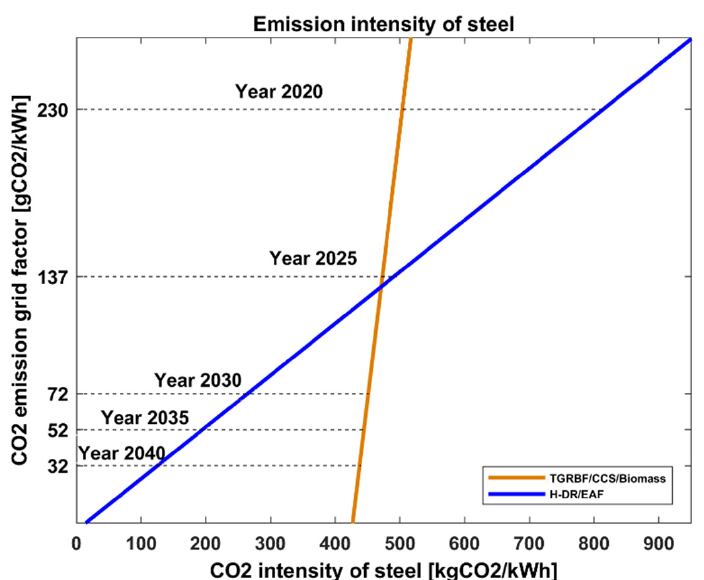
Figure 8. CO 2 emissions intensity of primary steelmaking in Pathway 1 ( orange ) and Pathways 2, 3 ( blue ) as function of future European CO 2 emission grid factor. The horizontal dotted lines indicate the development of the European CO 2 emission grid factors as estimated by IEA [44].